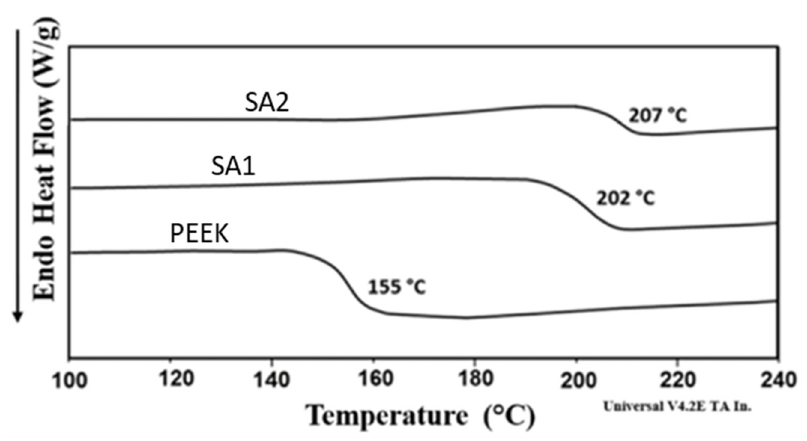
Figure 5. DSC curve of PEEK; SA-01 and